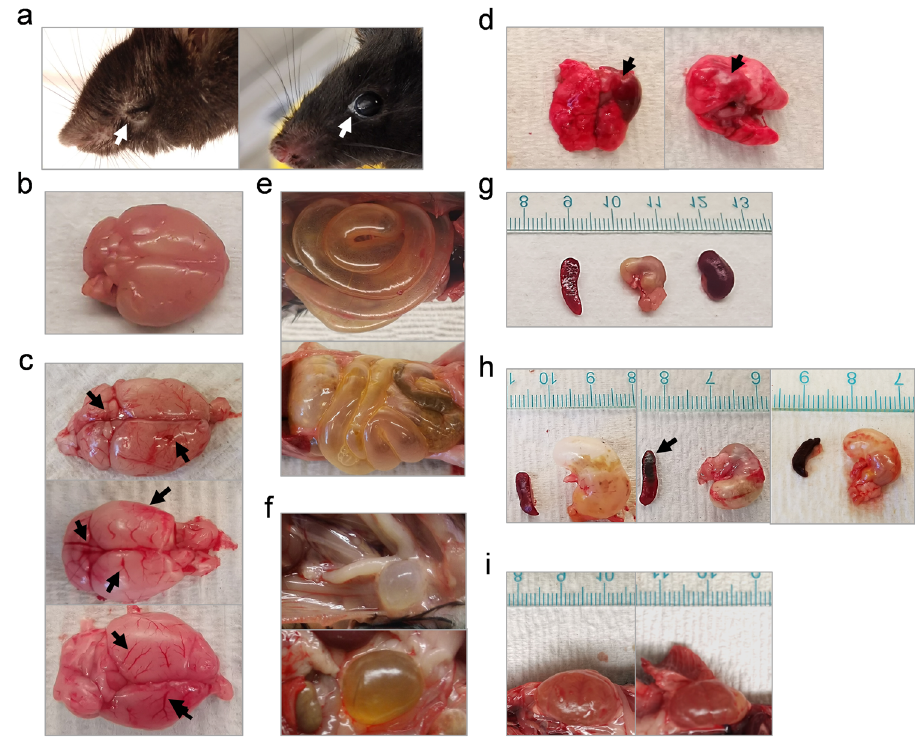
Fig. 2 Representative clinical symptoms of K18-hACE2 mice after infections of SARS-CoV-2 and variants. K18-hACE2 mice of both sexes (~1:1 ratio) were infected intranasally with USA-WA1/2020 (WA) of lineage A bearing 614D at 10 4 TCID 50 /mouse, New York-PV09158/2020 (NY) of lineage B.1.3 bearing 614G at 10 3 TCID 50 /mouse, USA/CA_CDC_5574/2020 (CA) of lineage B.1.1.7 at 10 2 TCID 50 /mouse or hCoV-19/South Africa/KRISP-EC- K005321/2020 (SA) of lineage B.1.351 at 10 2 TCID 50 /mouse, respectively. Representative images of infected mice and damaged tissues are shown. ( a ) in fl amed eyes; ( b ) normal brain; ( c ) infected brains with hemorrhage; ( d ) infected lungs with hemorrhage; ( e ) infected intestines with excessive gas; ( f ) infected enlarged bladders; ( g ) normal spleen, stomach and kidney; ( h ) swollen stomachs and hemorrhagic spleen after infection; ( i ) swollen kidneys of infected female mice. Arrows indicate where the lesions exist. Table 1 Frequency of symptoms observed in K18-hACE2 mice infected with SARS-CoV-2 and variants*.